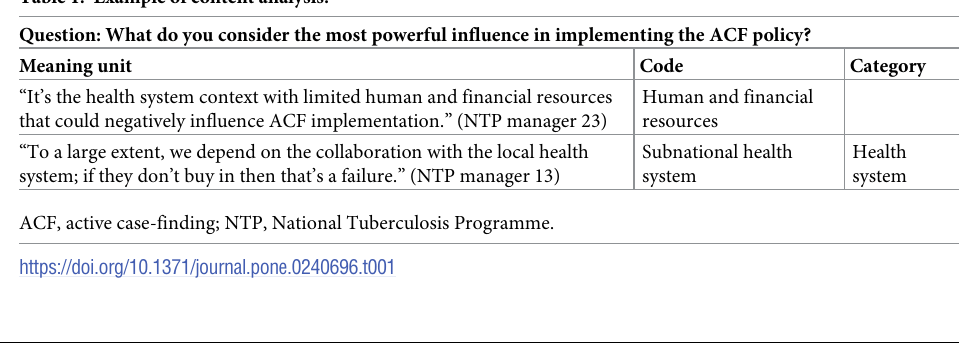
Table 1. Example of content